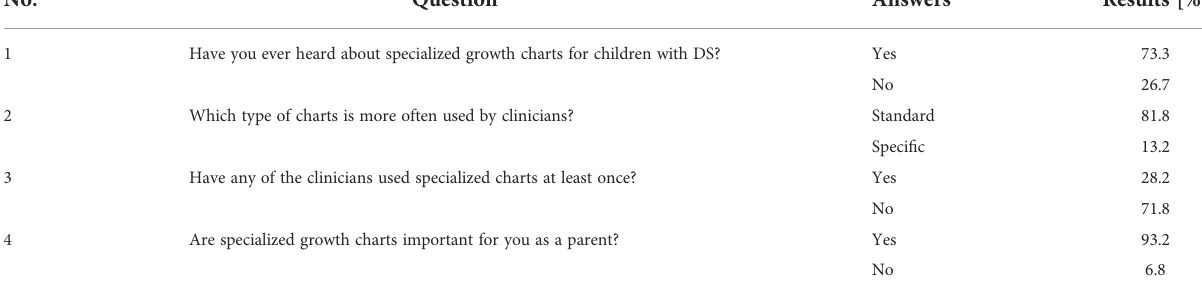
TABLE 4 Internet survey (questions with